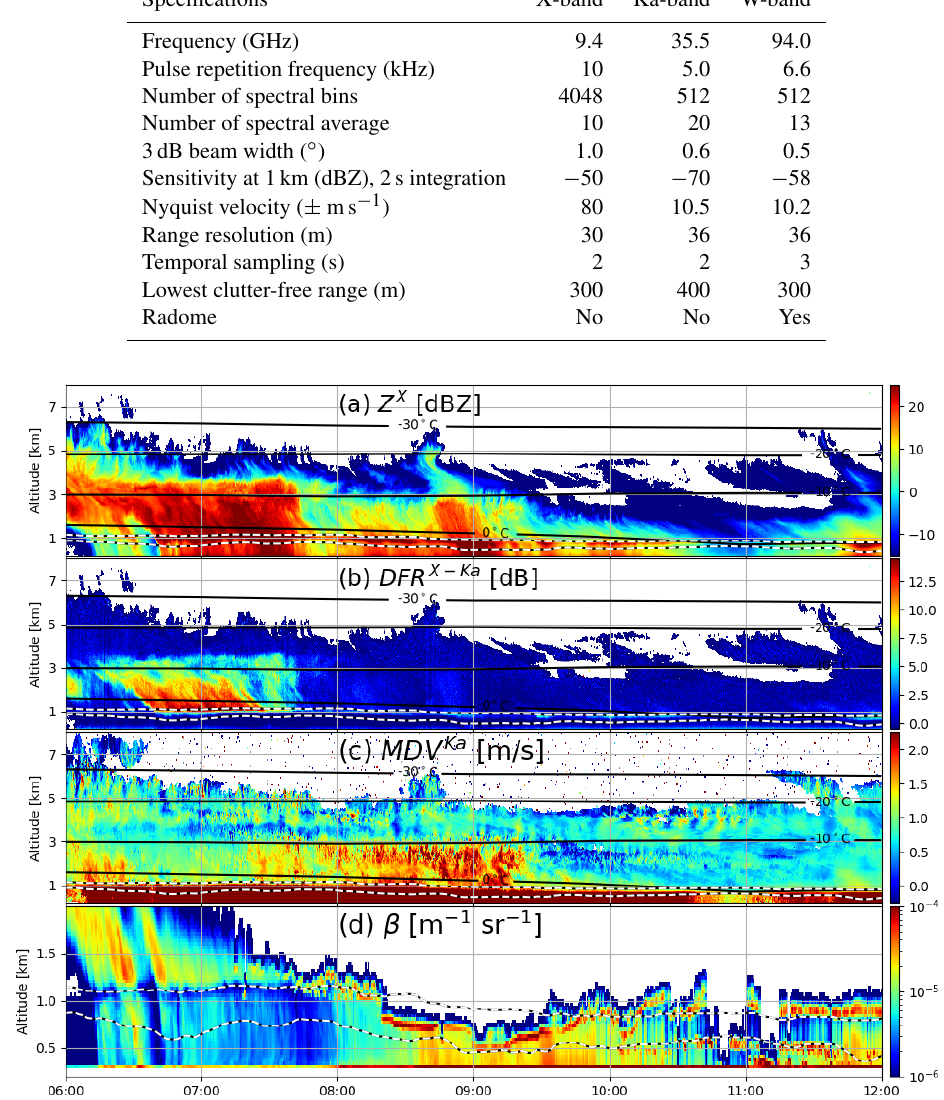
Figure 1. Time–height plots of radar variables measured at JOYCE on 24 November 2018: (a) X-band radar reflectivity factor (dBZ); (b) dual-frequency ratio (DFR) of X- and Ka-bands ( Z X − Z Ka ); (c) mean Doppler velocity (MDV, Ka-band); (d) lidar backscattering cross section (note the difference in the range of the presented altitudes). The dashed lines indicate the top and the bottom of the melting level derived from the Ka-band linear depolarization ratio (LDR). Black contour lines show isotherms derived from ECMWF